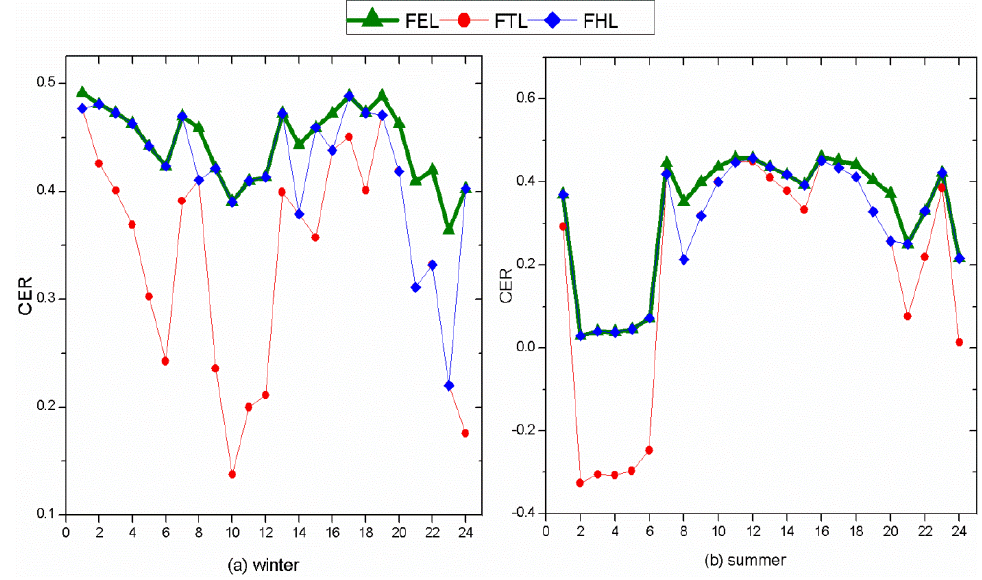
Figure 7. CER of different operation mode in representative ( a ) winter and ( b ) summer days based on simulated